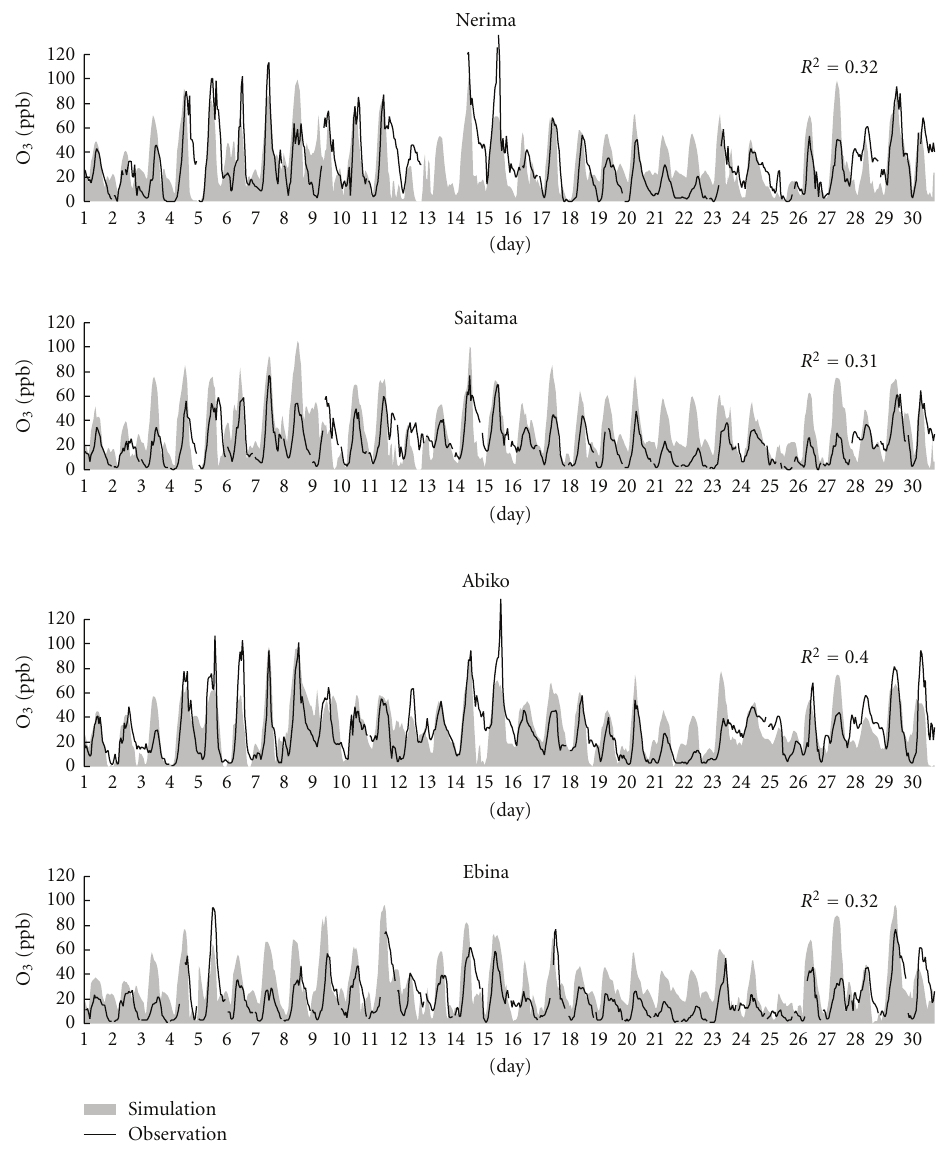
Figure 9: Time series for observed and simulated hourly ozone concentrations at some sites during August